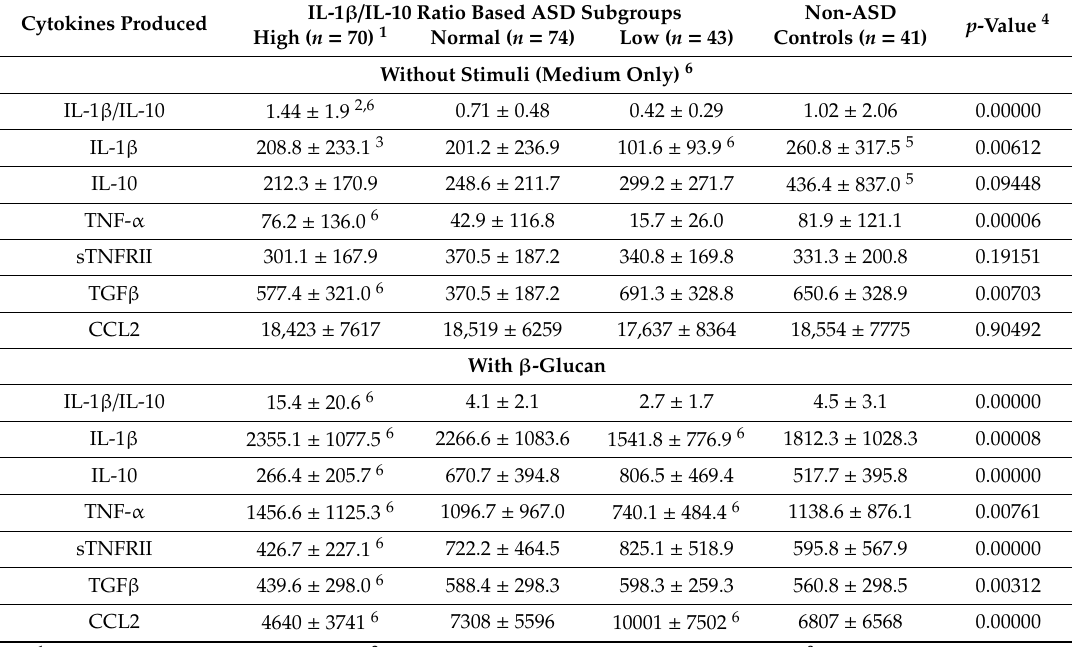
Table 3. Changes in IL-1 β / IL-10 ratios and monocyte production in the IL-1 β / IL-10 based ASD subgroups under β -glucan stimulated culture